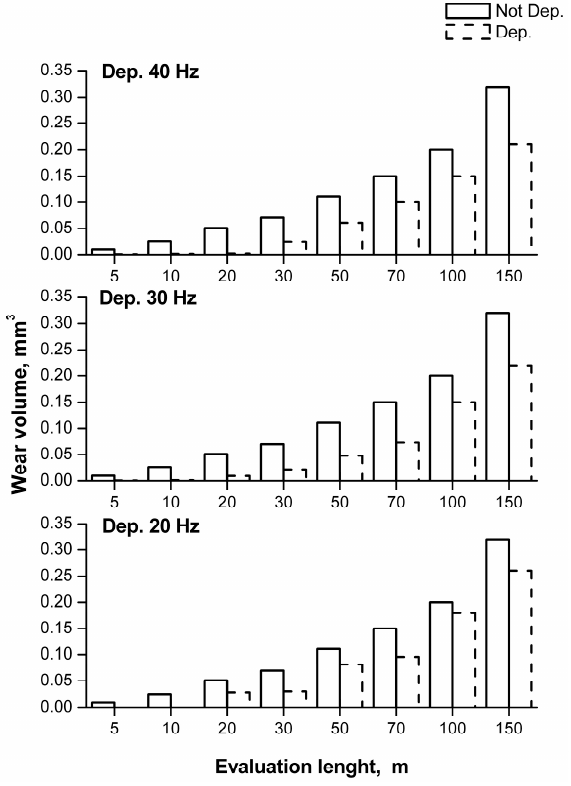
Figure 13. Removed volume function of the distance covered by the indenter.